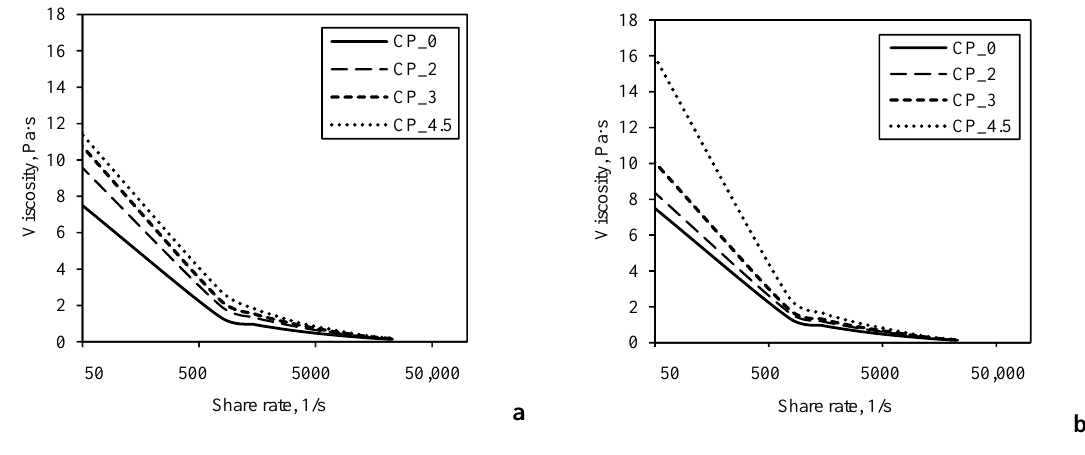
Figure 1. Viscosity curves of yogurt made by adding different amount of CP after ( a ) and before fermentation ( b ). Figure 1 . Viscosity curves of yogurt made by adding different amount of CP after (a) and before fermentation (b) Table 2. Physicochemical and rheological properties of yogurt made by adding different amounts of CP after (I method) and before fermentation (II